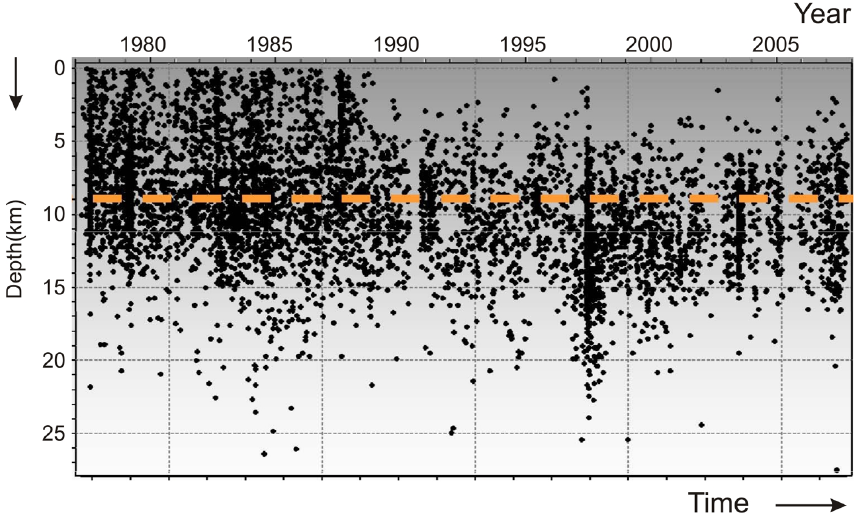
Figure 11. Time evolution of the hypocentral depths according to the Hypo71 algorithm. Orange dashed line shows a flat, constant trend.